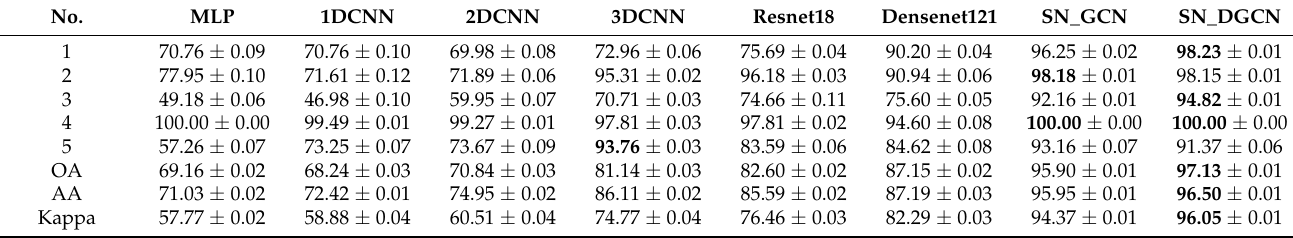
Table 2. Comparison of classification performance of different models (%). Note: Bold represents the highest classification